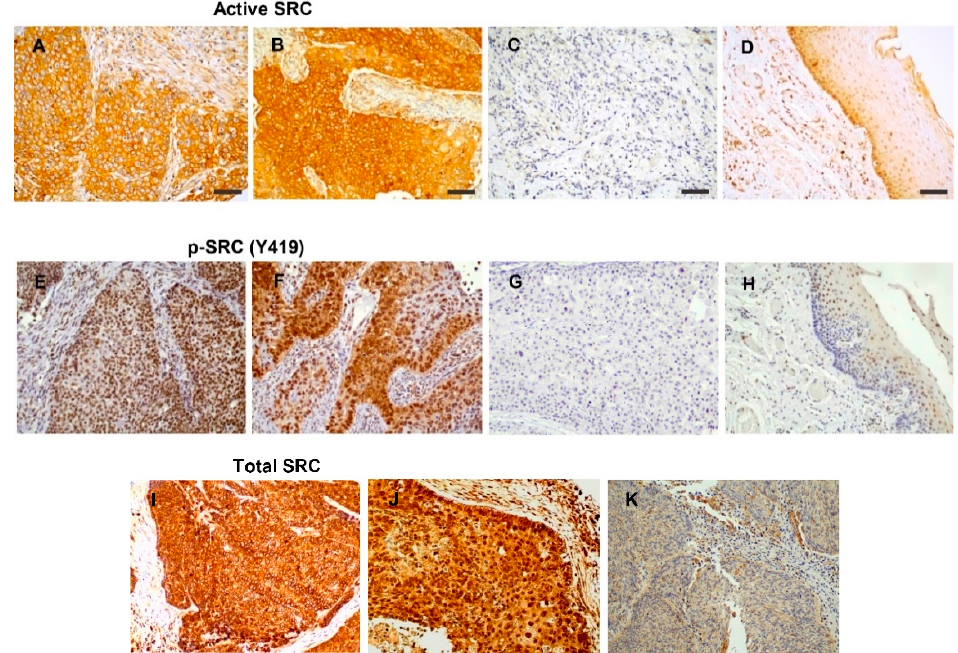
Figure 1. Immunohistochemical analysis of SRC expression in head and neck squamous cell carcinoma (HNSCC) tissue specimens. Representative examples of HNSCC showing positive active SRC staining ( A and B , cytoplasmic and membrane enrichment), negative staining ( C ), and normal adjacent epithelia ( D ). Representative examples of tumors with positive p ‐ SRC (Tyr419) staining ( E , nuclear and F , cytoplasmic and nuclear), negative staining ( G ), and normal adjacent epithelia ( H ). Representative examples of tumors showing positive total SRC staining ( I and J , cytoplasmic and nuclear) and negative staining ( K ). Magnification 20×. Scale bars = 50 μ m.